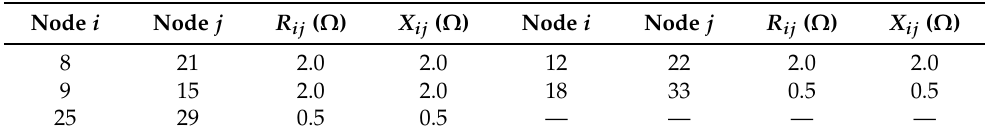
Table 8. Distribution lines added to the IEEE 33-bus